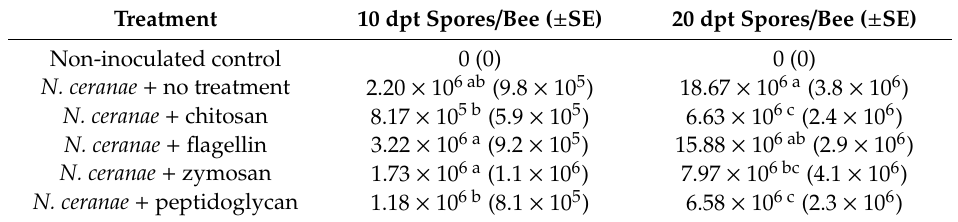
Table 1. Mean (±SE) N. ceranae spores per bee at 10 and 20 dpt following no inoculation (non-inoculated control) or inoculation with 1 × 10 5 spores of N. ceranae only ( N. ceranae + no treatment), N. ceranae and 1.0 µg/µL chitosan ( N. ceranae + chitosan), 0.10 µg/µL flagellin ( N. ceranae + flagellin), 0.125 µg/µL zymosan ( N. ceranae + zymosan) or 1.0 µg/µL peptidoglycan ( N. ceranae + peptidoglycan).